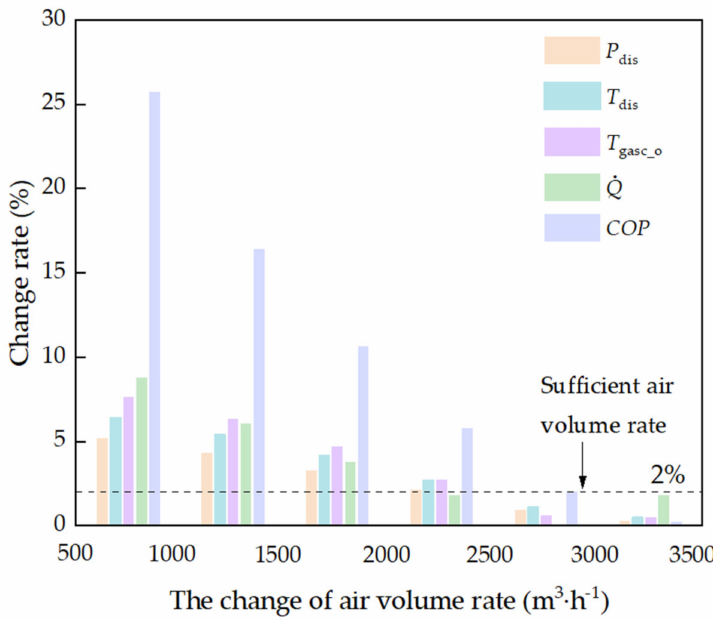
Figure 6. Change rate of evaluation parameters and performance parameters with air volume flow rate in the gas